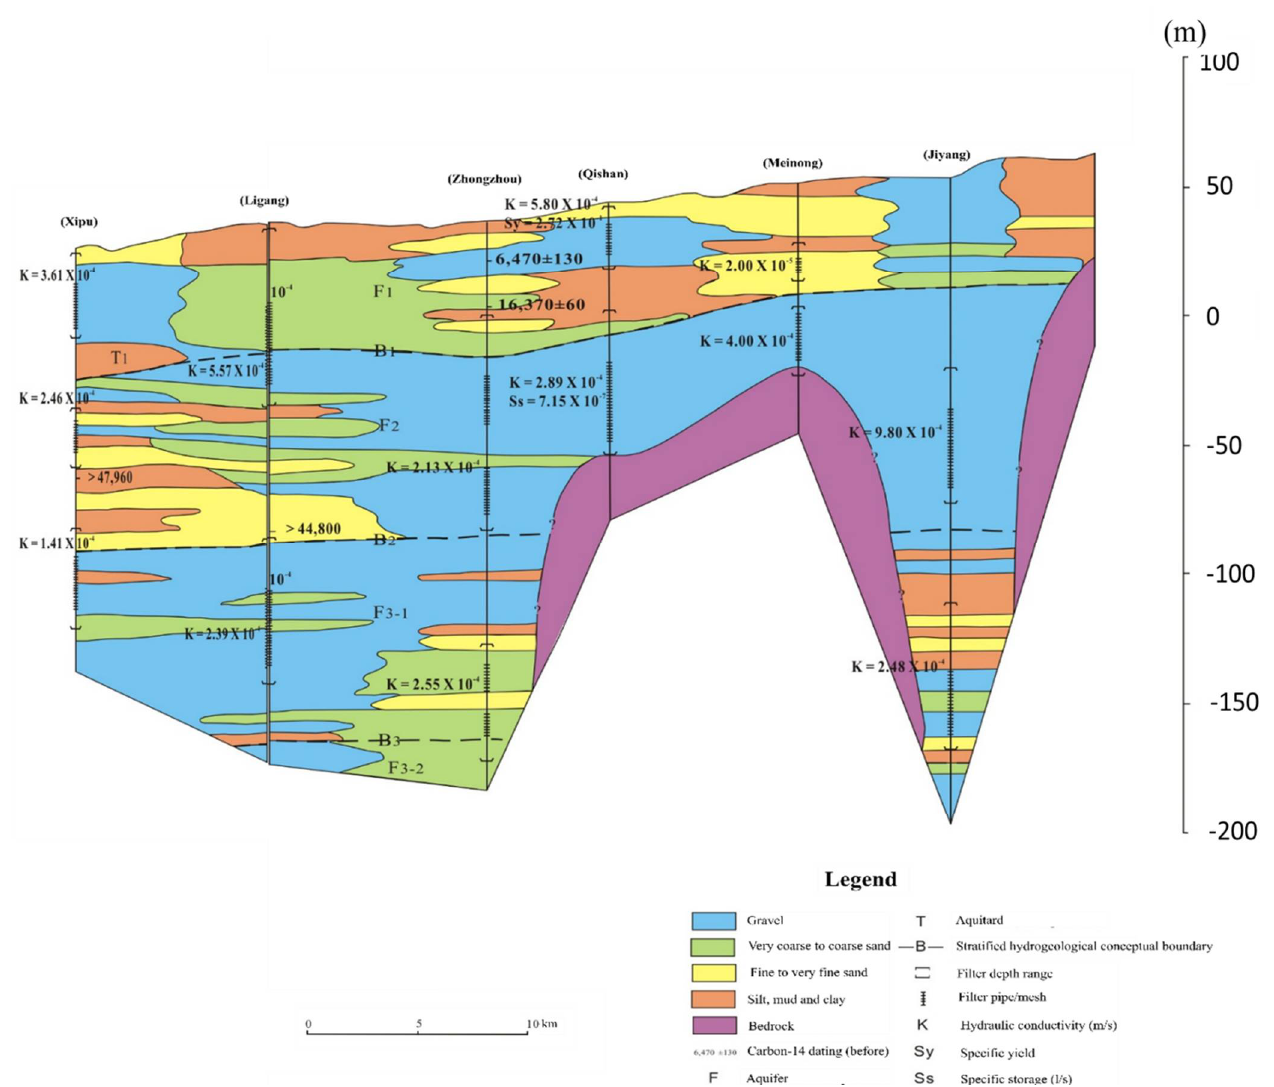
Figure 2. The geological cross-section along the black line is in Figure 1.